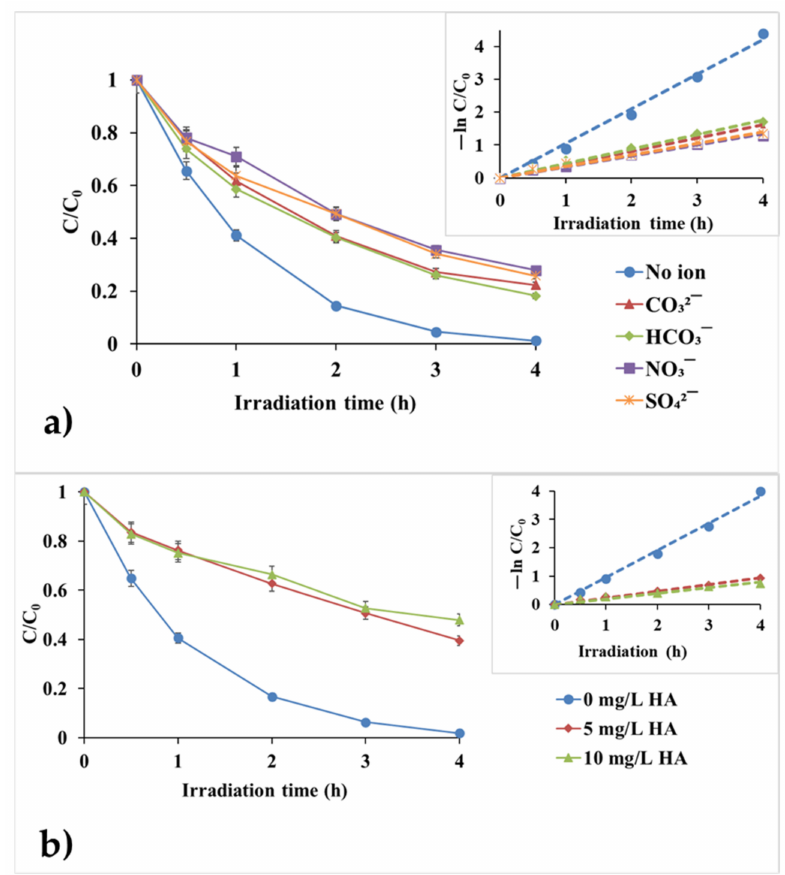
Figure 13. ( a ) Anion effect at 1 mM concentration of each tested anion, and ( b ) humic acid effect and their corresponding photodegradation rate constant (inset) (1 g Ag-ZnSnO 3 , [ CAF] 0 = 10 mg/L, initial pH =